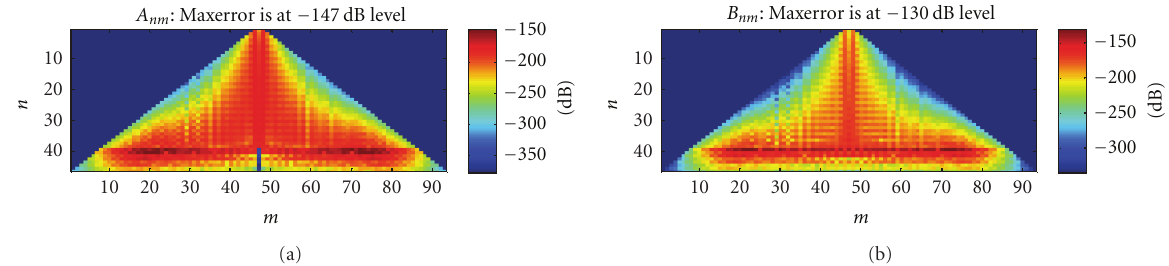
Figure 6: Error plots of the spherical expansion coe ffi cients computed from the higher-order probe output with ψ = 2 ◦ by truncating the M matrix. (a) is E (38) and (b) plot is E (38) . A nm B nm